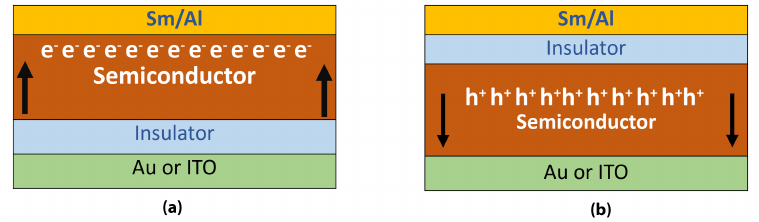
Figure 5. Structure of the device for ( a ) electron selection ( b ) hole selection [111].